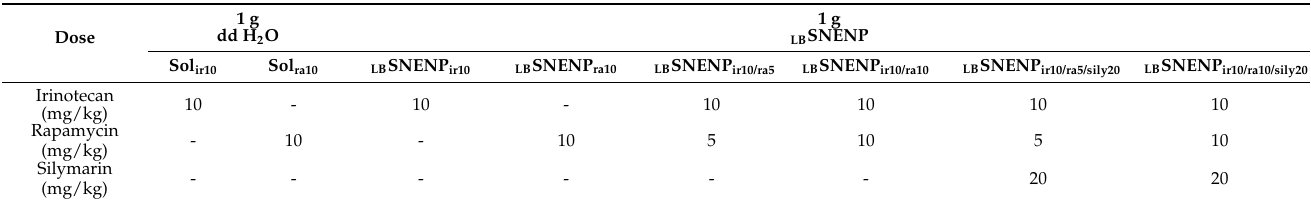
Table 3. The dose of irinotecan, rapamycin, and silymarin in each group of PK studies.